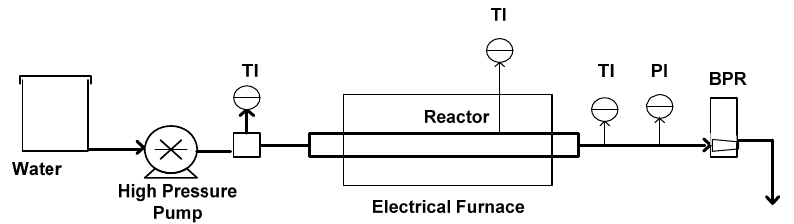
Figure 1. Setup for hydrothermal carbonization (HTC) of reed biomass to produce biochar. Table 2. Experiment summary and results.